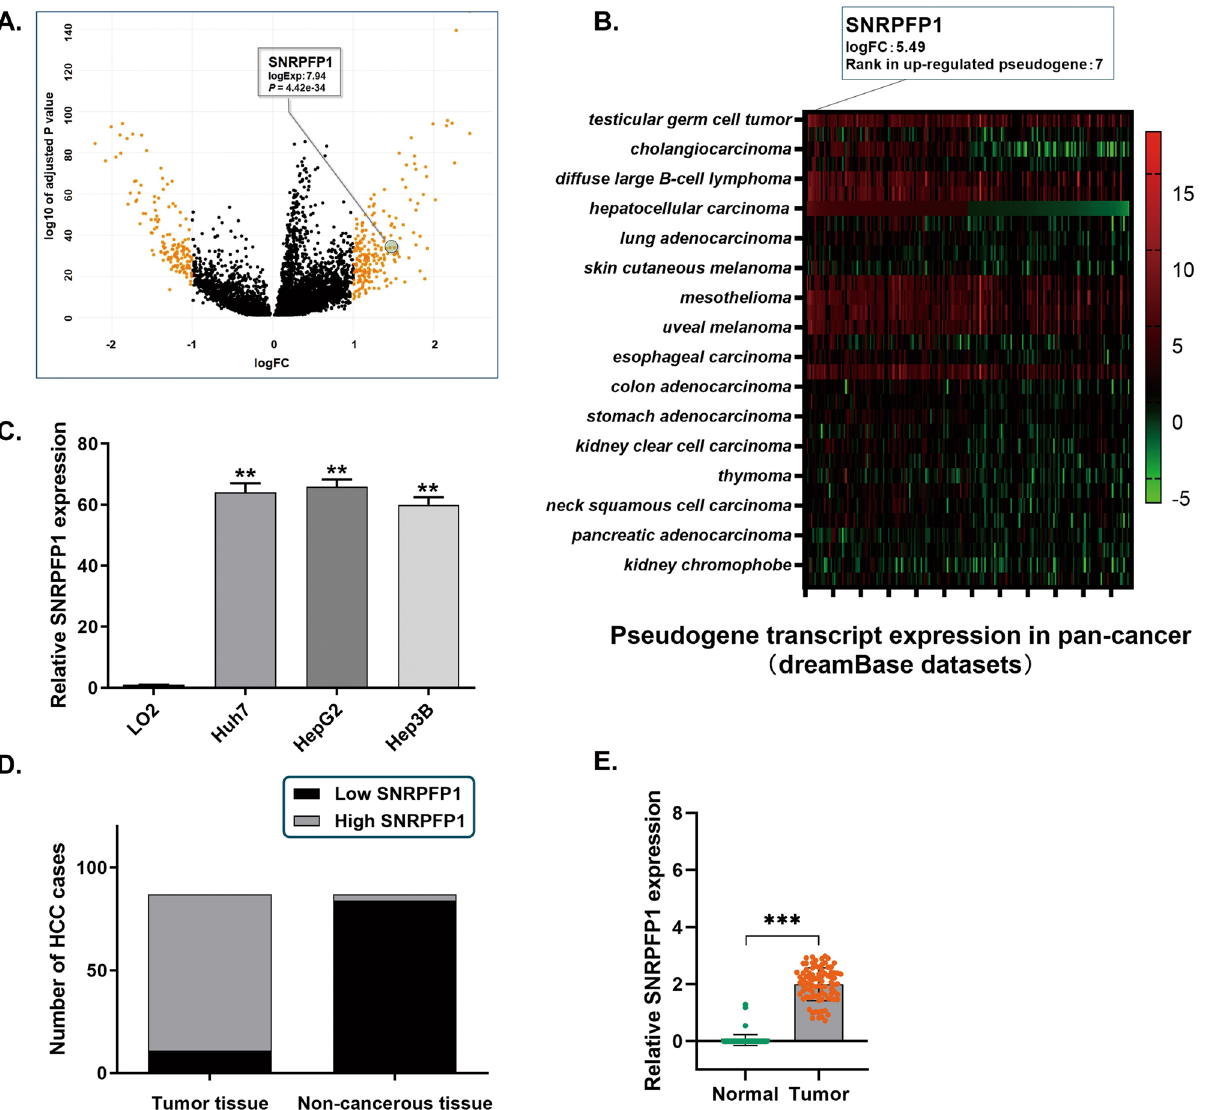
Figure 1. Pseudogene SNRPFP1 activated to highly transcribe in HCC cell lines and tissues. ( A ) Analysis of the data from the LCLE. Pseudogene SNRPFP1is transcriptionally activated and presents a high expression